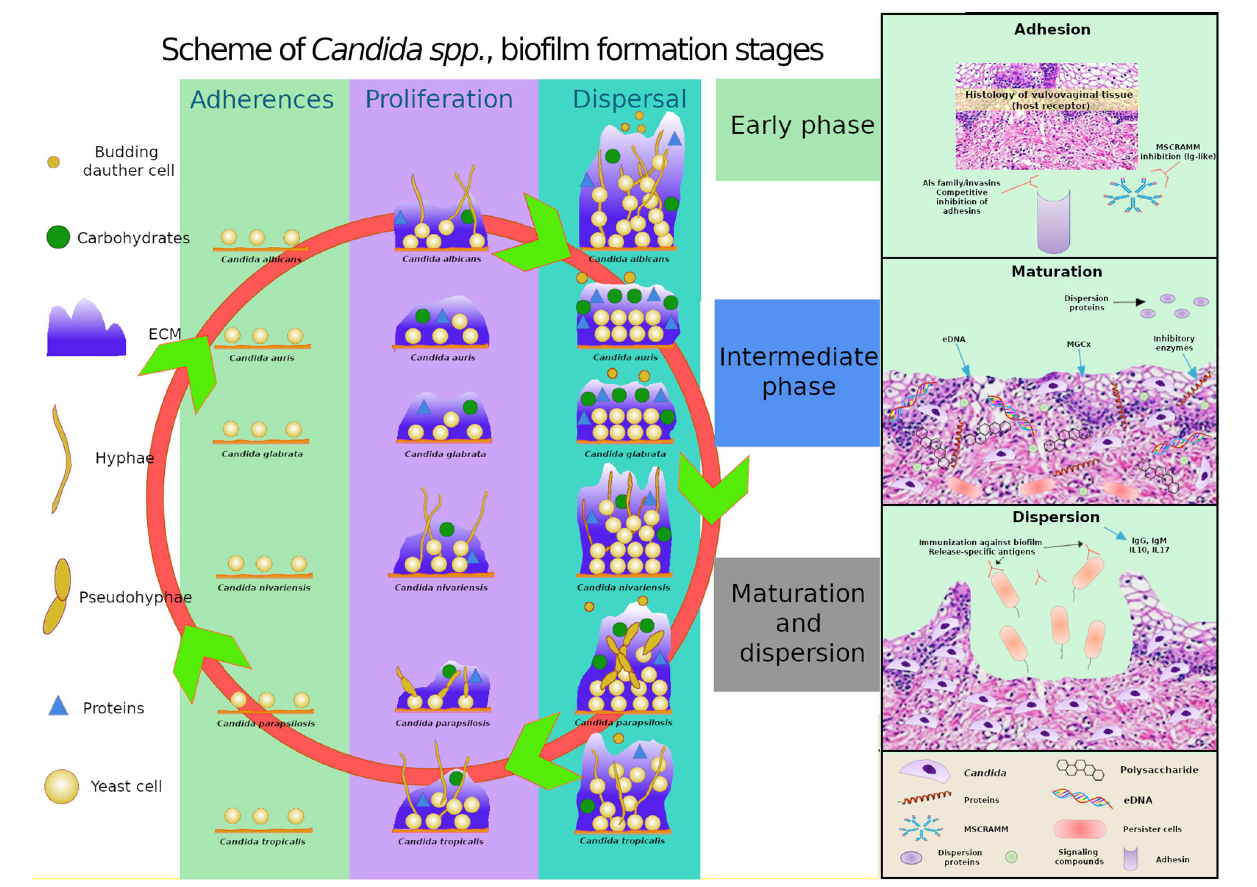
FIGURE 3 | Comparative schematics of three stages of biofilm formation in C. albicans, C. glabrata, C. tropicalis, and C. parapsilosis, C. auris and C. nivariensis highlighting the different capacities of the species in producing extracellular matrix (ECM), the varying components present in the ECM, and the ability of the species to exhibit different cell morphologies, and highlights of the transcriptional factors involved in adhesion, extracellular polymeric substances, filamentation, and biofilm formation. MSCRAMM, microbial surface components recognizing adhesive matrix molecules; MGCx, extracellular matrix mannan-glucan complex; eDNA, external